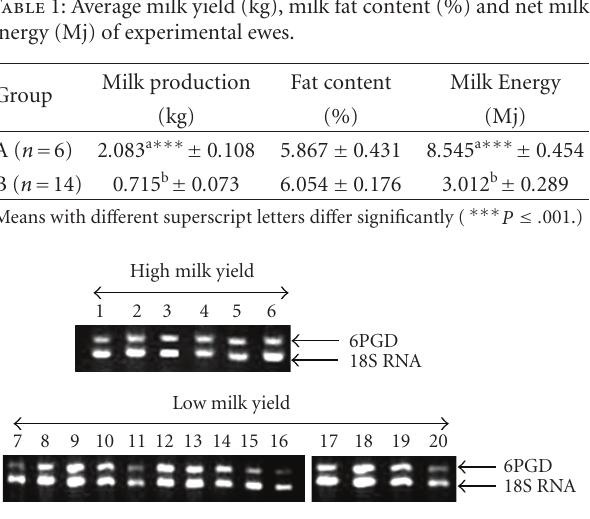
Figure 1: Expression analysis of 6PGD gene in tail adipose tissue of high and low milk yield ewes. All samples were normalized to 18S RNA gene. 10 μ L of each sample were loaded in the agarose gel for electrophoresis. As the experimental conditions were the same for all the samples, the observed di ff erences in the low milk yield group may be due to di ff erences concerns the sample itself.